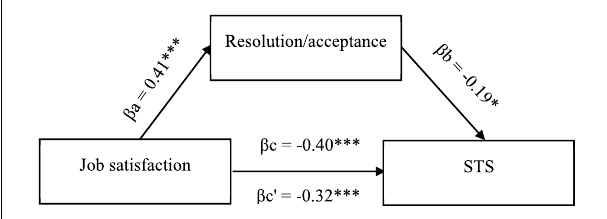
FIGURE 1 | Model of associations between job satisfaction, cognitive coping strategy in the form of resolution/acceptance, and STS. β a,b, indirect effect;